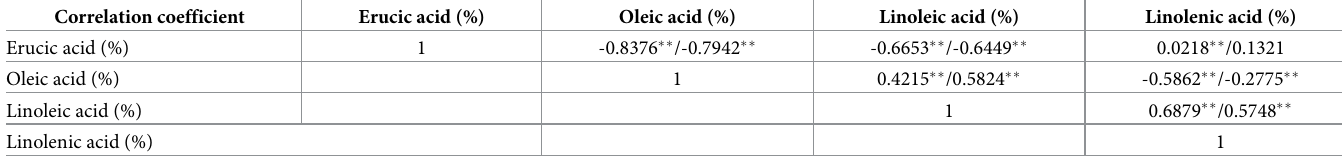
Table 3. The correlation analyses four fatty acid composition of B . napus in JXAU/JXIRS. Correlation